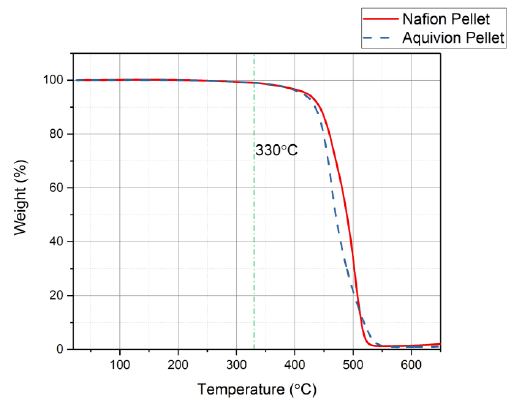
Figure 7. Thermogravimetric Analyzer (TGA) results showing that both precursor ionomers have the same thermal degradation temperature at 330 °C.